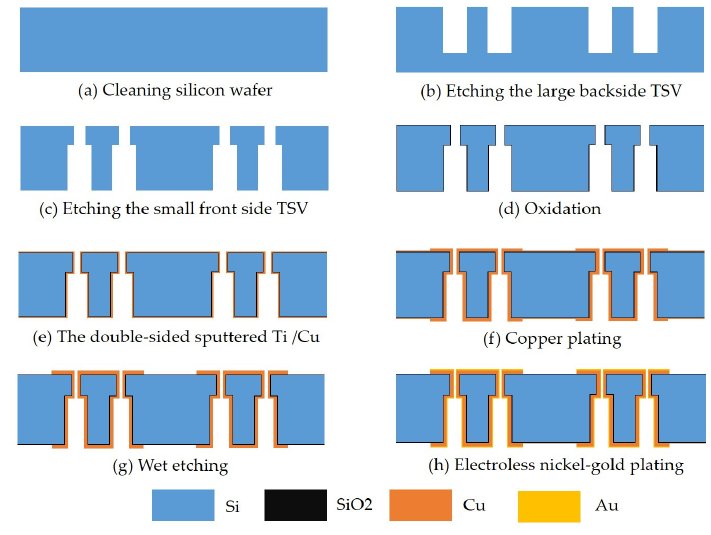
Figure 8. Process design.